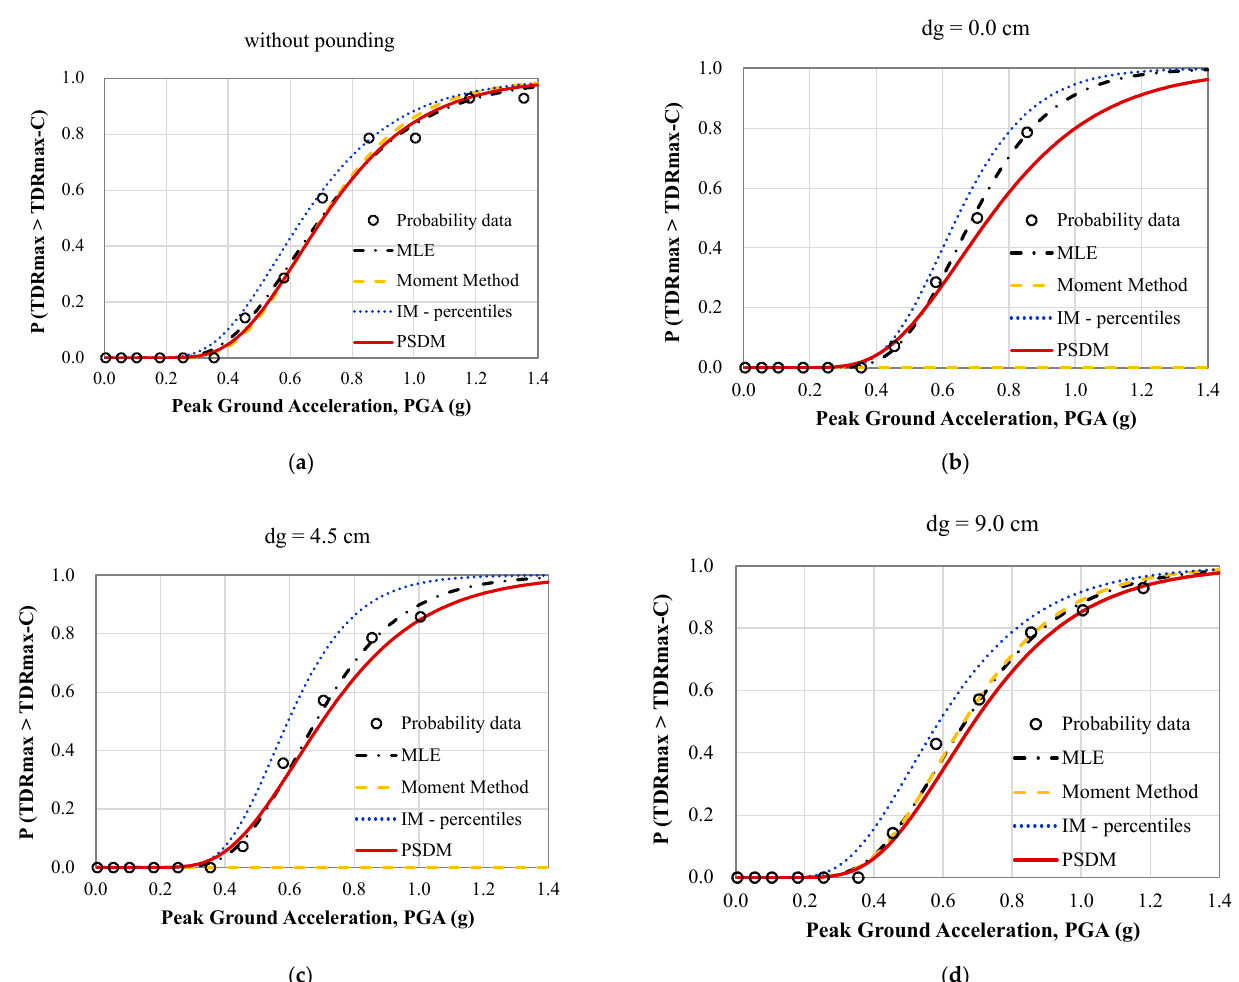
Figure 6. MLE, MM, IM percentiles, PSDM methodologies for the fragility assessment of the eight-story RC frame in terms of maximum top drift (TDR max -%H tot ) as a function of the PGA. Examined cases: ( a ) without the pounding effect, ( b ) d g = 0.0 cm, ( c ) d g = 4.5 cm, and ( d ) d g = 9.0 cm.